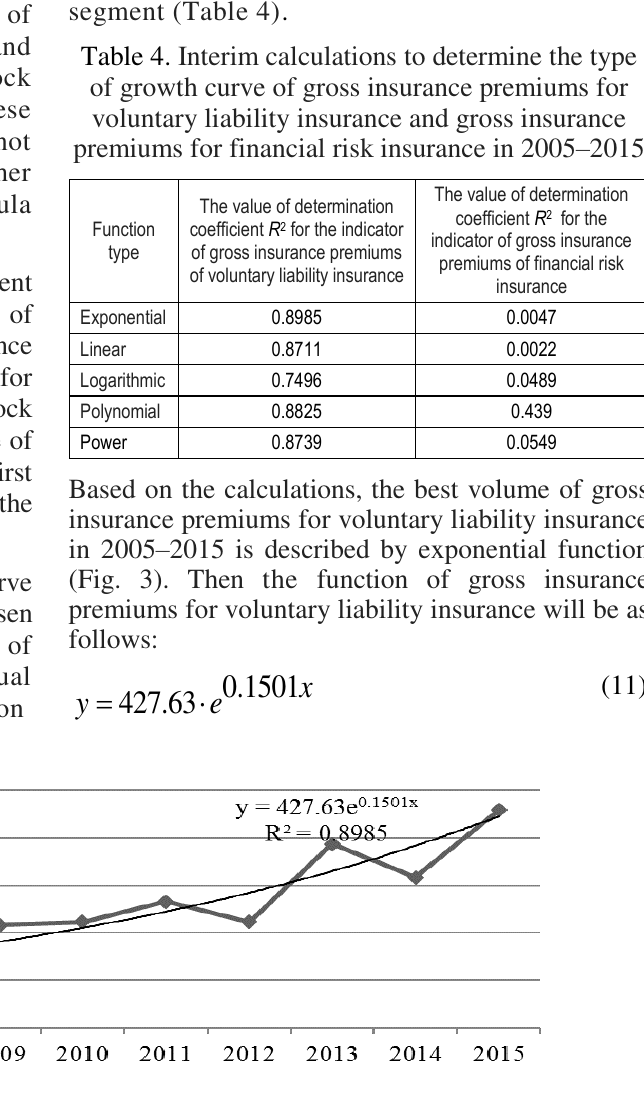
Fig. 3. Determination of the type of growth curve for the indicator of gross insurance premiums for voluntary